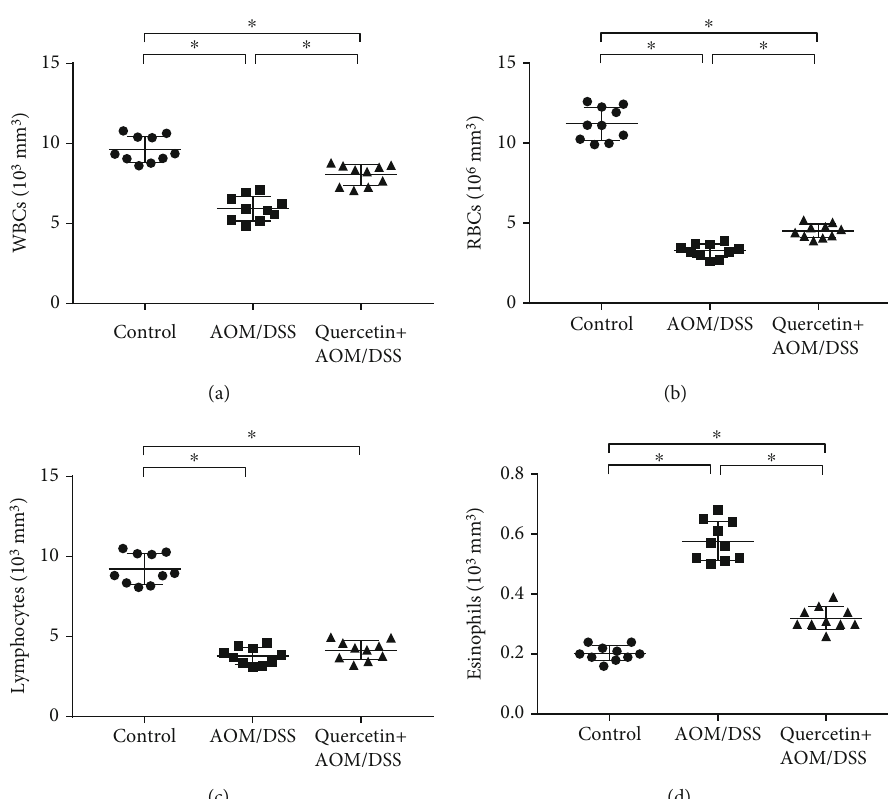
Figure 3: Quercetin helps protect the hemopoietic system. (a) Quanti fi cation of plasma concentration of WBCs in control and experimental mice. (b) Quanti fi cation of plasma concentration of RBCs in control and experimental mice. (c) Quanti fi cation of plasma concentration of lymphocytes in control and experimental mice. (d) Quanti fi cation of plasma concentration of eosinophils in control and experimental mice. Data are expressed as mean values ± SD ( n = 10 /group). ∗ P < 0 : 05 , Student ’ s t